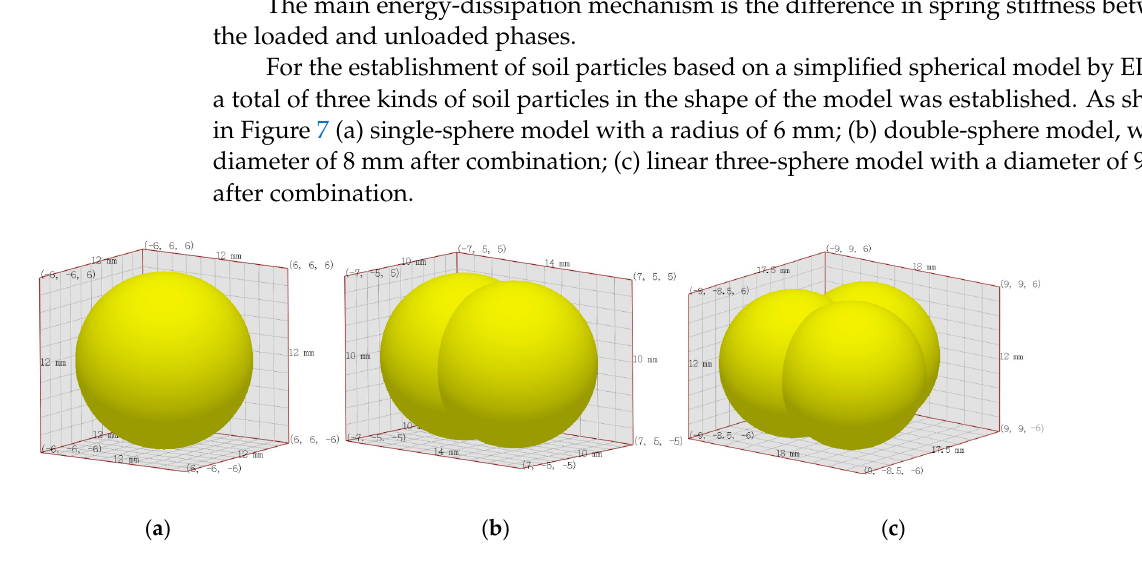
( f ) 2.1 s Figure 9. Cutting process simulation diagram.